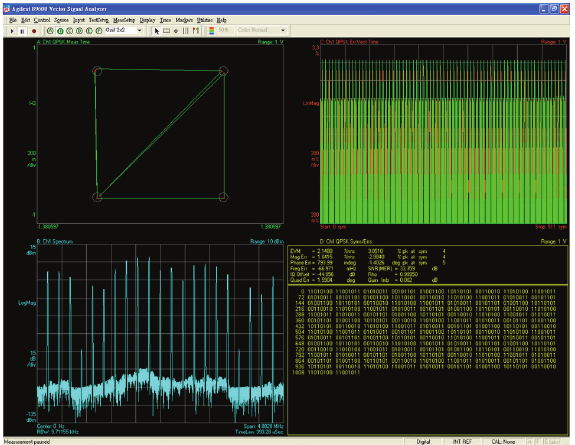
Figure12:UsingtheAgilent89600vectorsignalanalyzertomonitor the constellation points of the transmitter.